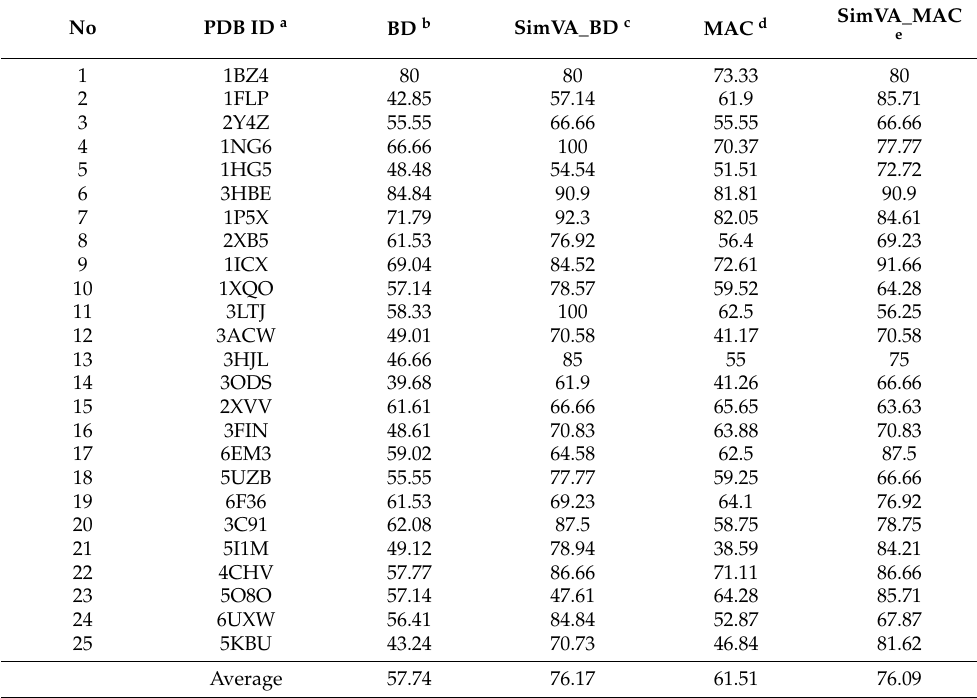
Table 4. The accuracy of the method incorporating the SimVA algorithm.